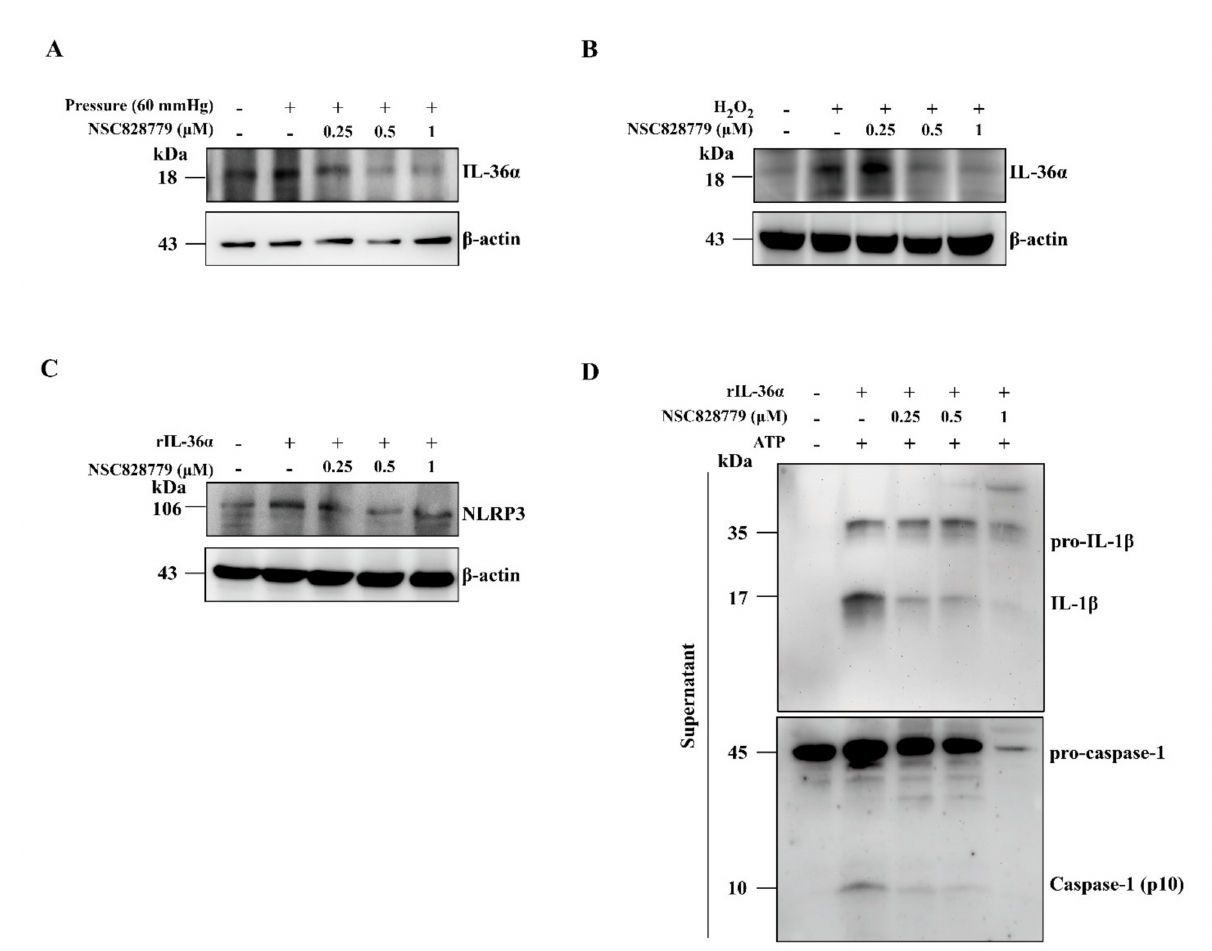
Figure 4. NSC828779 inhibits IL-36a expression in renal TECs induced by a cell-based, mechanically induced constant pressure model or H 2 O 2 . Renal TECs (a murine renal tubular epithelial cell line) were incubated for 30 min with or without NSC828779, cultured in a MICP model at 60 mmHg or H 2 O 2 for 24 h, with or without 10 mM ATP (1 h). Western blot analysis for IL-36 α protein expression in cells by MICP ( A ) and H 2 O 2 ( B ). Cells were incubated for 30 min with or without NSC828779 and 24 h with or without 300 ng/mL of rIL-36 α for NLRP3 expression ( C ). Representative Western blots for IL-1b and caspase-1 ( D ) in the supernatant of cells incubated for 30 min with or without NSC828779, then for 24 h with or without 300 ng/mL of rIL-36 α , and with or without ATP (1 h). Data are shown as means ± SEM for three separate experiments, and each experiment was performed in triplicate. NSC828779, a salicylanilide derivative. TECs, tubular epithelial cells. MICP, mechanically induced constant